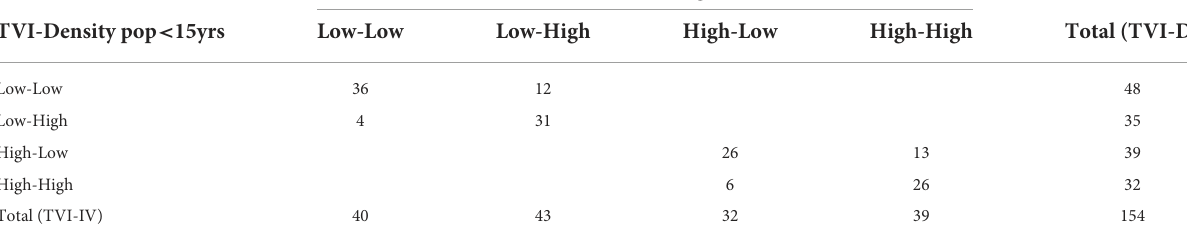
TABLE 5 Distribution of the UAs according to the combinations between the levels of TVI-D and